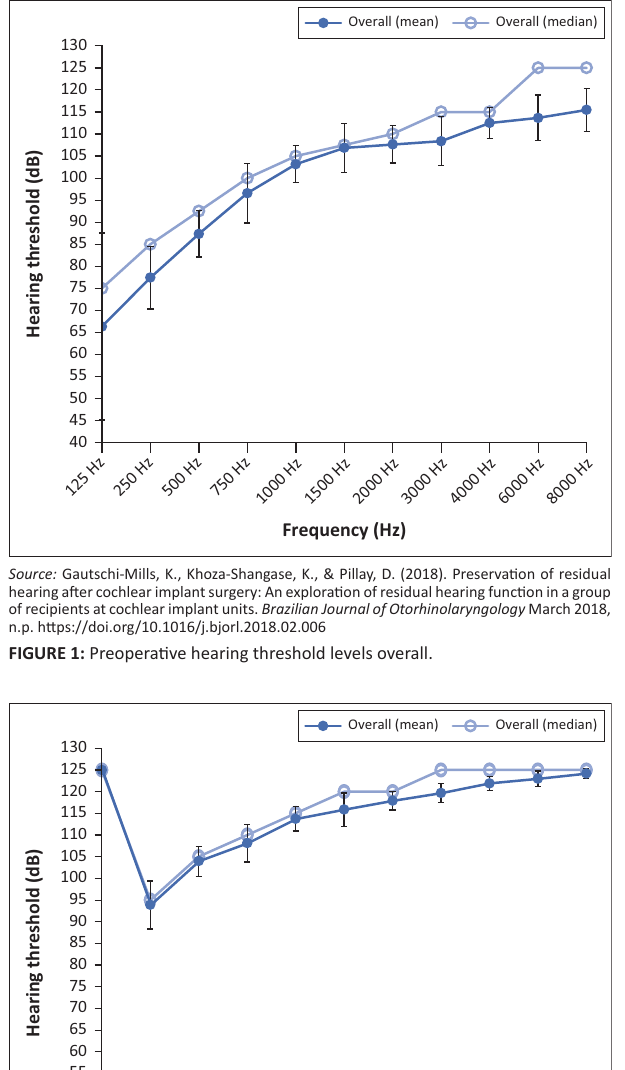
TABLE 1: Aetiologies of hearing loss found in the current study.